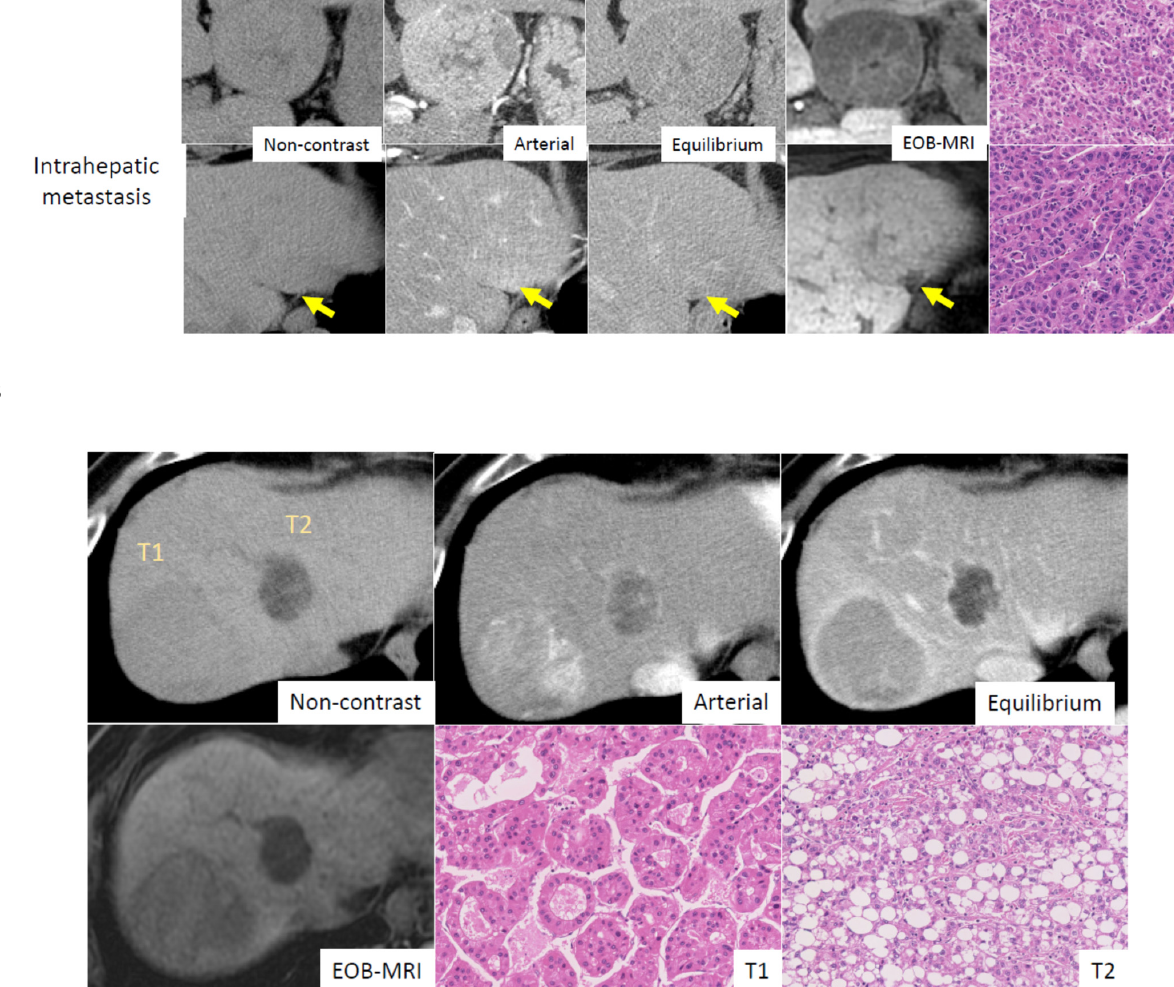
Figure 3 . Radiological-, and pathological features in multiple HCC ( A ) Intrahepatic metastasis. Primary tumor shows early enhancement and late washout pattern on CT and shows low intensity on EOB- MRI. Intrahepatic metastatic small lesion shows almost identical enhancement pattern to primary tumor. Histological features are similar between primary and intrahepatic metastatic lesion, which are moderately differentiated HCC with trabecular pattern. Courtesy of Dr. Akihisa UENO (Keio University, Tokyo, Japan). ( B ) Multicentric occurrence. Tumor No.1 (T1) shows early enhancement and late washout pattern on CT and shows uptake of gadolinium ethoxybenzyl diethylenetriaminepentaacetic acid (Gd-EOB- DTPA) on gadoxetic acid-enhanced magnetic resonance imaging (EOB-MRI). Histologically, tumor shows a moderately differentiated HCC with pseudoglandular pattern. Tumor No.2 (T2) shows low attenuation on non-contrast CT, indicating fatty component, and weak early enhancement and late washout. EOB-MRI reveals low intensity, which means no uptake of Gd-EOB-DTPA. Tumor pathology is steatohepatitic HCC. Courtesy of Dr. Akihisa UENO (Keio University, Tokyo,